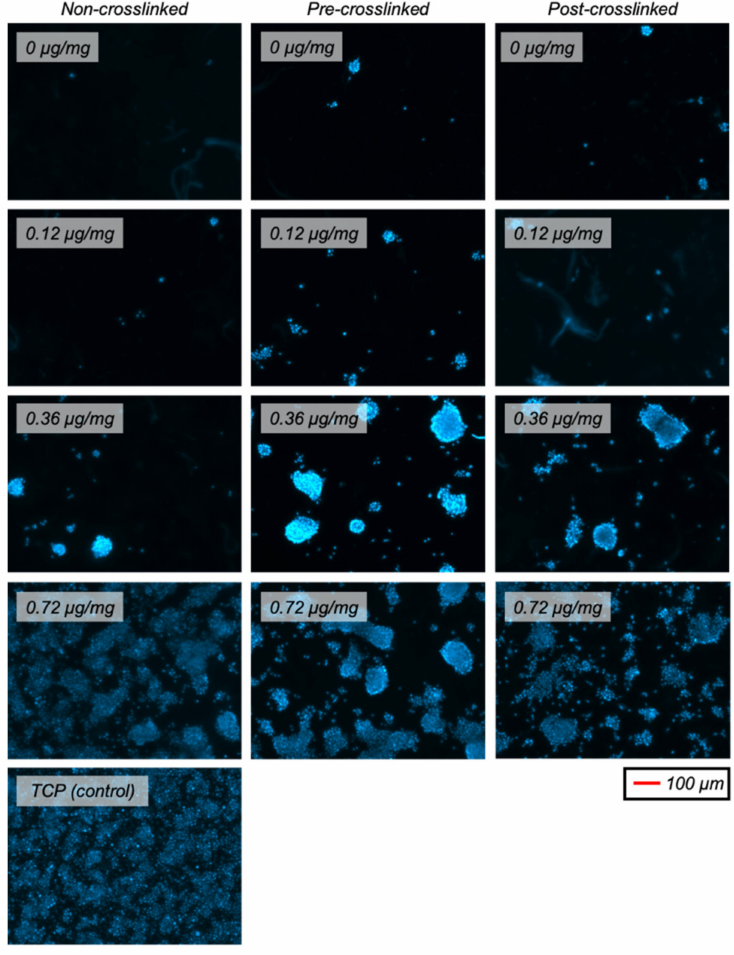
Figure 10. Representative fluorescent images (DAPI-stained nuclei) of RSCs on various collagen (or TCP) substrates after 3 days in